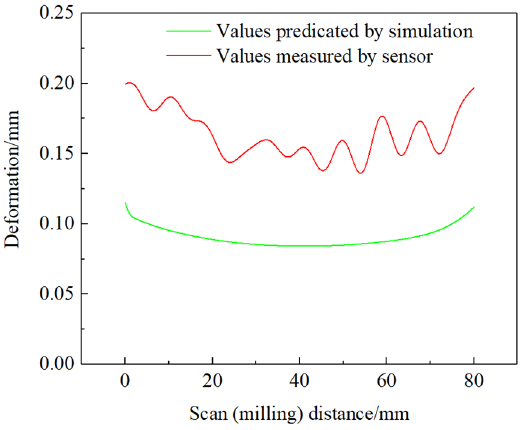
Figure 23. Comparison of deformation ( a ) and deformation statistics ( b ) before and after milling on the top of laser cladding thin-walled parts.